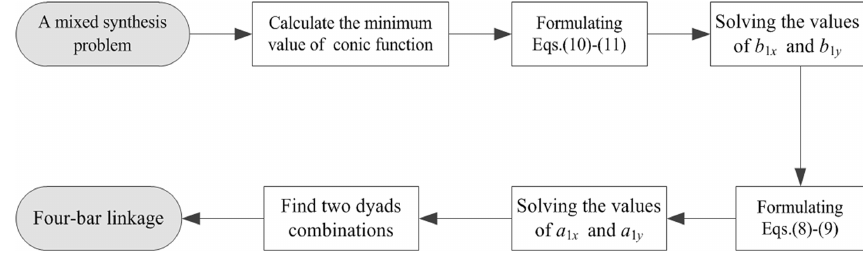
Figure 3. Flowchart of the mixed synthesis method. Table 1. Comparison of studied cases and methods in different research.